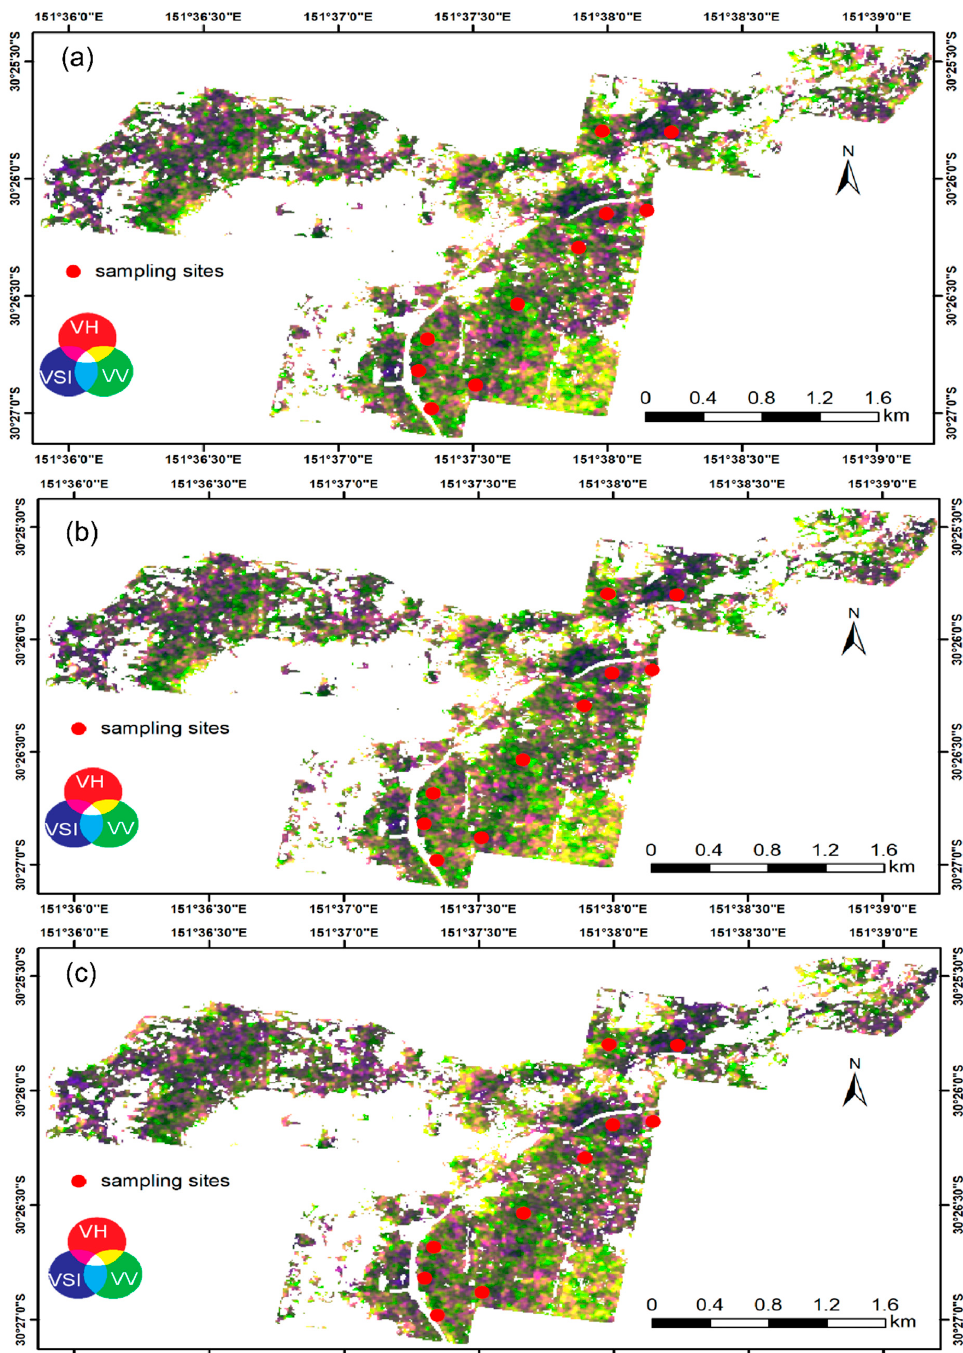
Figure 5. True colour composite images for backscattering coefficients processed with digital elevation model of varied spatial resolutions; ( a ) 90 m, ( b ) 30 m and ( c ) 1 m. The red colour in the image denotes the VH cross-polarisation, the green colour denotes the VV co-polarisation while the blue colour represents the volume scattering index (VSI). The image is the study site without non-herbaceous land cover types. Pixels in white colour represent masked land cover types or image